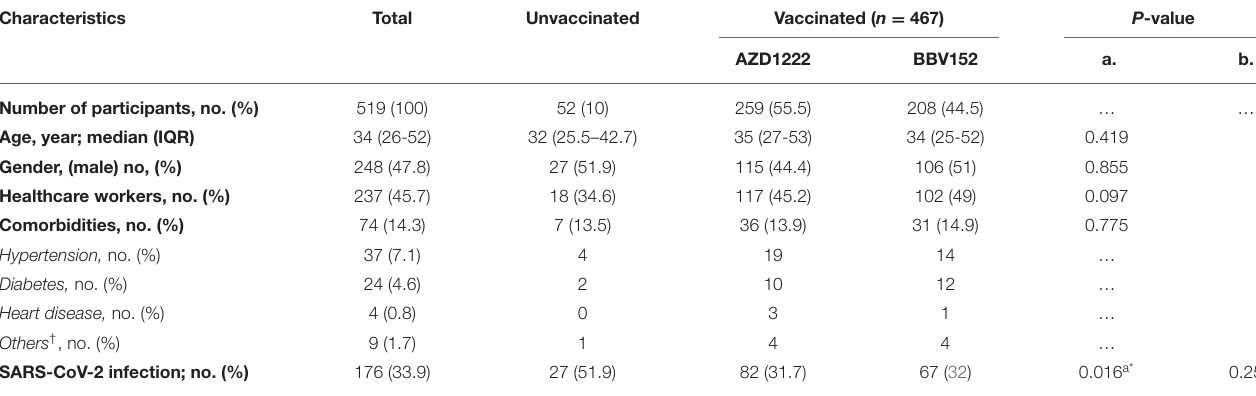
TABLE 1 | Clinico-demographic characteristics of the Chennai, India study cohort.